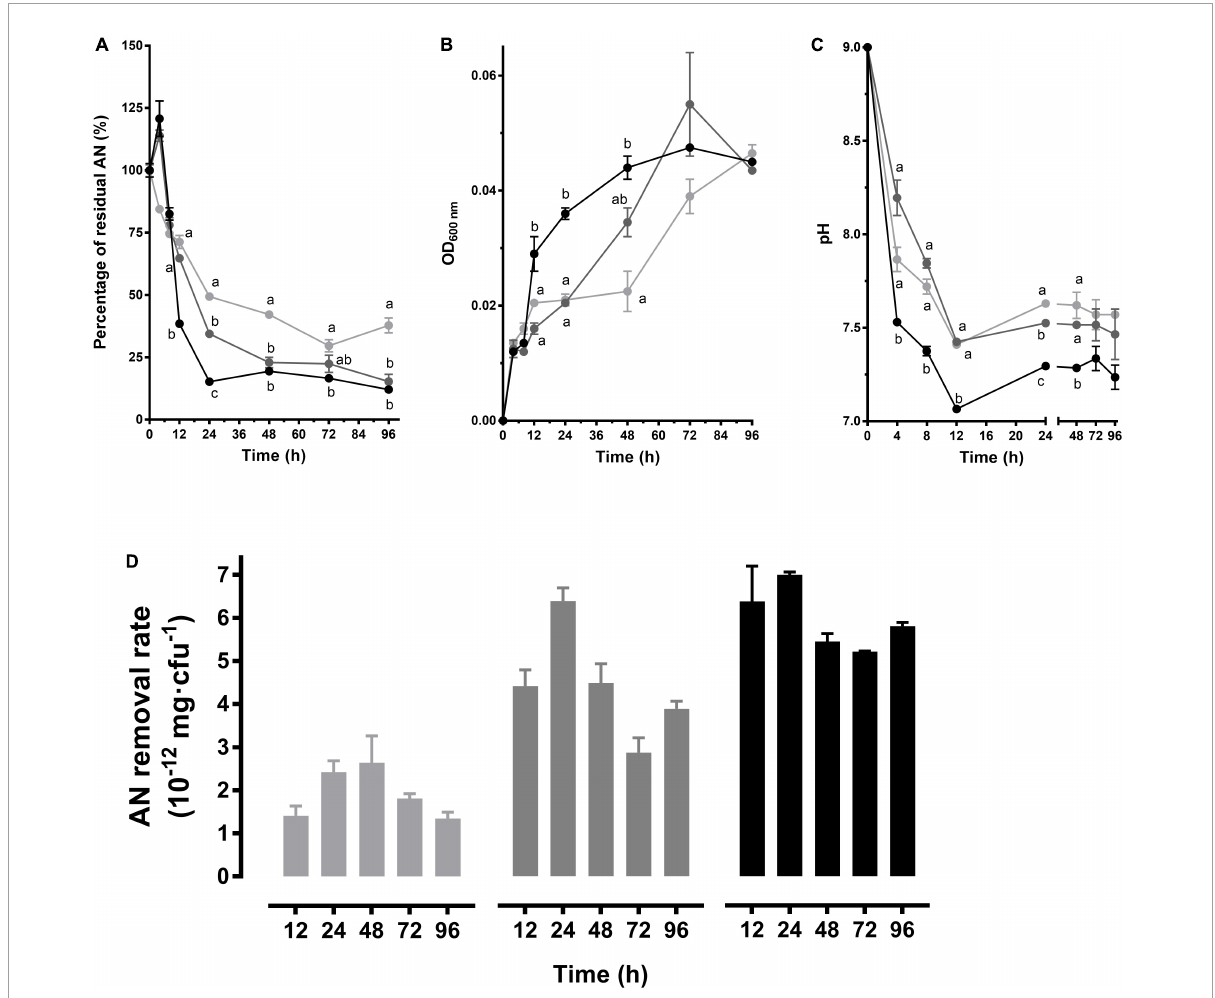
FIGURE4 AN removal characteristics of P. oleovorans CT-WL5-6. The residual AN percentage (A) , OD 600 nm (B) , and pH (C) determined within 96 h were shown. Values of each time point with different superscripts in (A–C) were significantly different ( P < 0.05). (D) The removal rate (AN quantity per cell) in 0–12 h, 0–24 h, ... , 0–96 h of incubation. In (A–D) , lines or column in light gray, dark gray, and black color, respectively, represents 1, 2, and 3 mg/L initial AN concentration